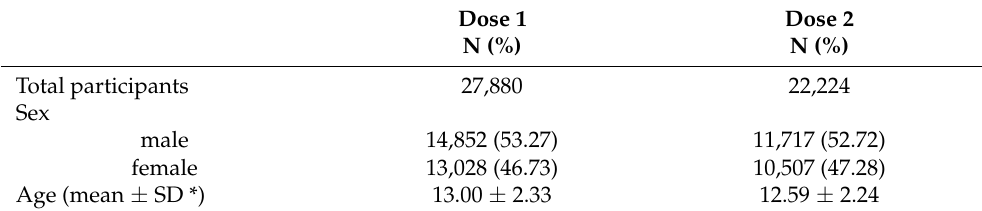
Table 1. Demographic characteristics of participants for both vaccine doses.